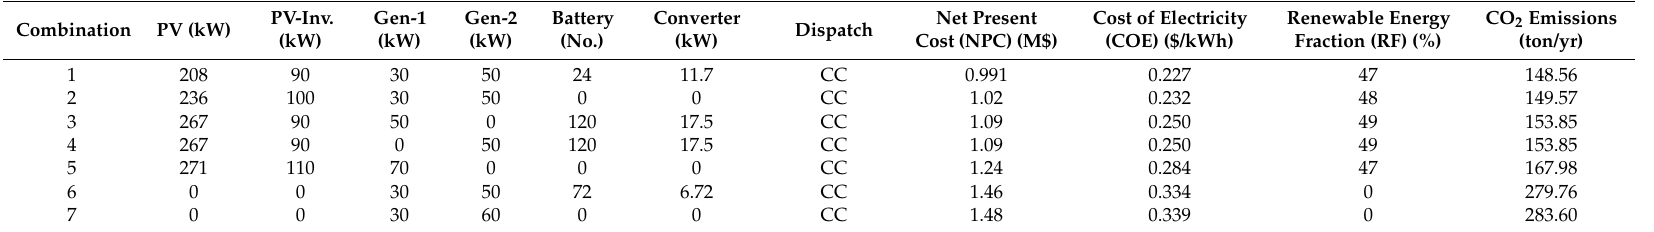
Table 3. Economic and environmental parameters of different optimised systems for